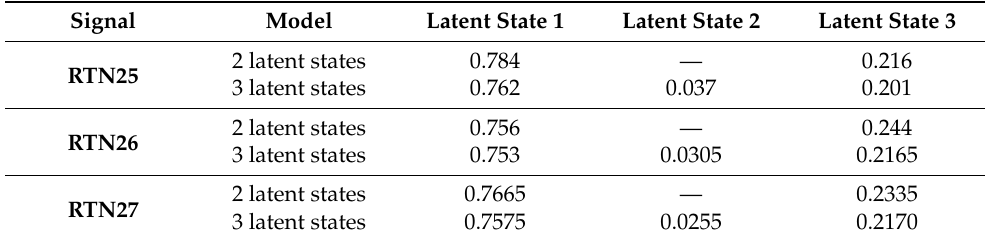
Table 1. Proportional number of times that each chain was in the latent states.